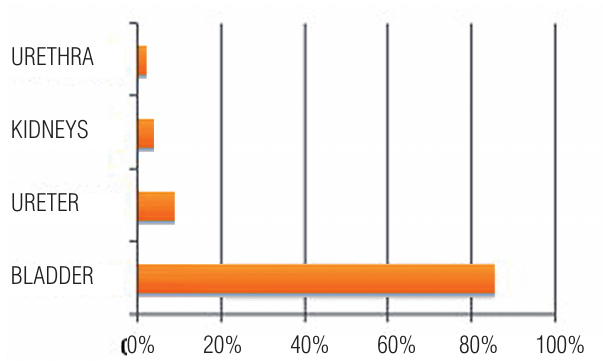
Figure 1B - Transvaginal ultrasound with endometriotic endovesical lesion. (N)